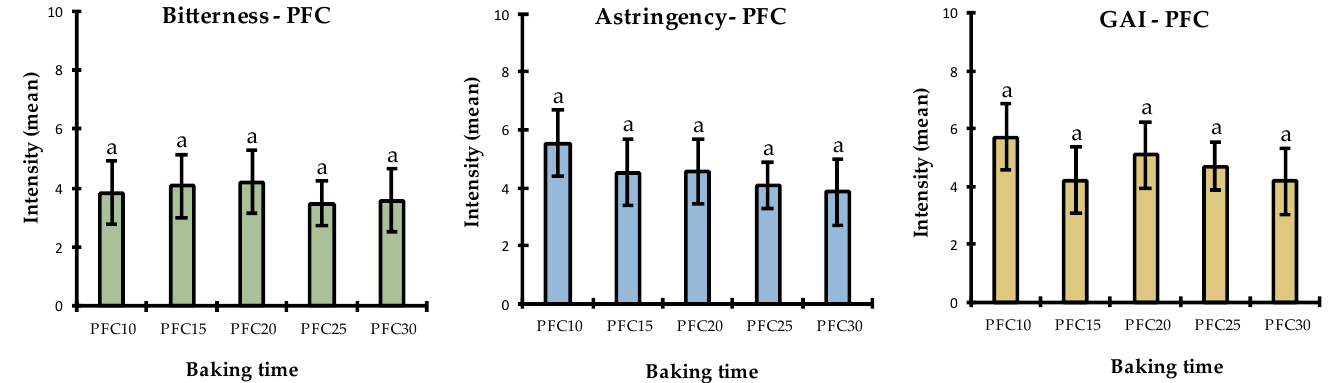
Figure 4. Mean intensities of the three attributes (bitterness, astringency, and aroma) assessed by the sensory panel in PFC samples over baking time. Significantly different means ( p < 0.05) are represented by letters above each bar. PFC10 = pea flour cake baked for 10 min, PFC15 = pea flour cake baked for 15 min, PFC20 = pea flour cake baked for 20 min, PFC25 = pea flour cake baked for 25 min, and PFC30 = pea flour cake baked for 30 min. GAI = global aromatic intensity.